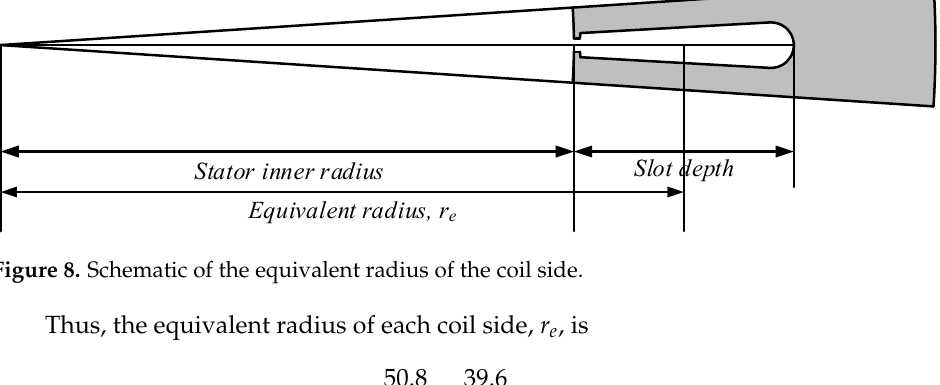
Figure 8. Schematic of the equivalent radius of the coil side.